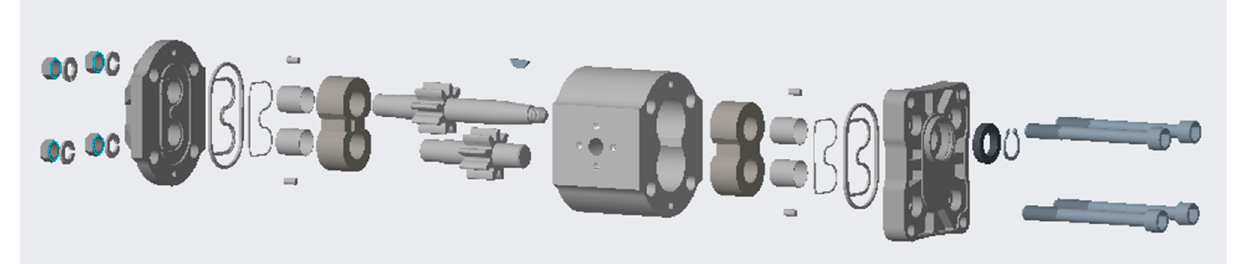
Figure 7. Exploded view of the hydraulic external gear pump.